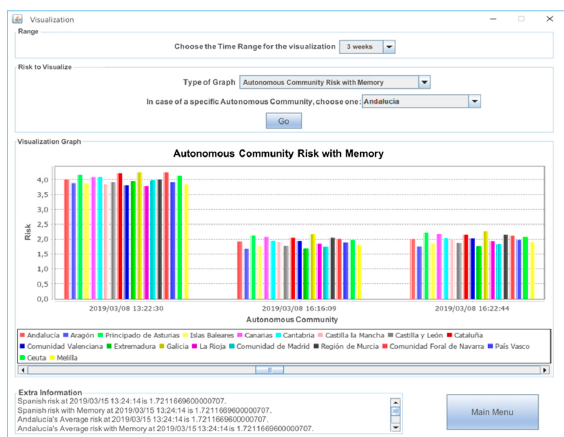
Figure 11. Visualization of the histogram of the risks of the di ff erent autonomous communities (ACs). The upper section o ff ers a selection menu to determine the temporal analysis window, in this case, 3 weeks. The second section allows you to select the administration you want to view, being able to select one or all ACs. The lower section shows the selected display. This example shows a histogram that includes all the ACs of